Question: Condense the content of this figure into a single sentence.
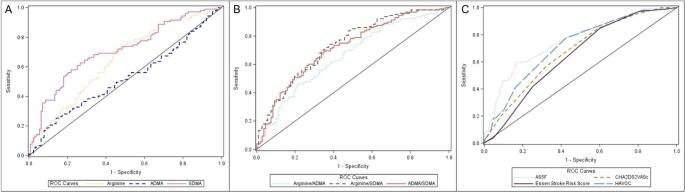
Answer: ROC-analysis for distinguishing between CES and ESUS with ( A ) biomarker levels, ( B ) biomarker ratios and ( C ) AF-scores